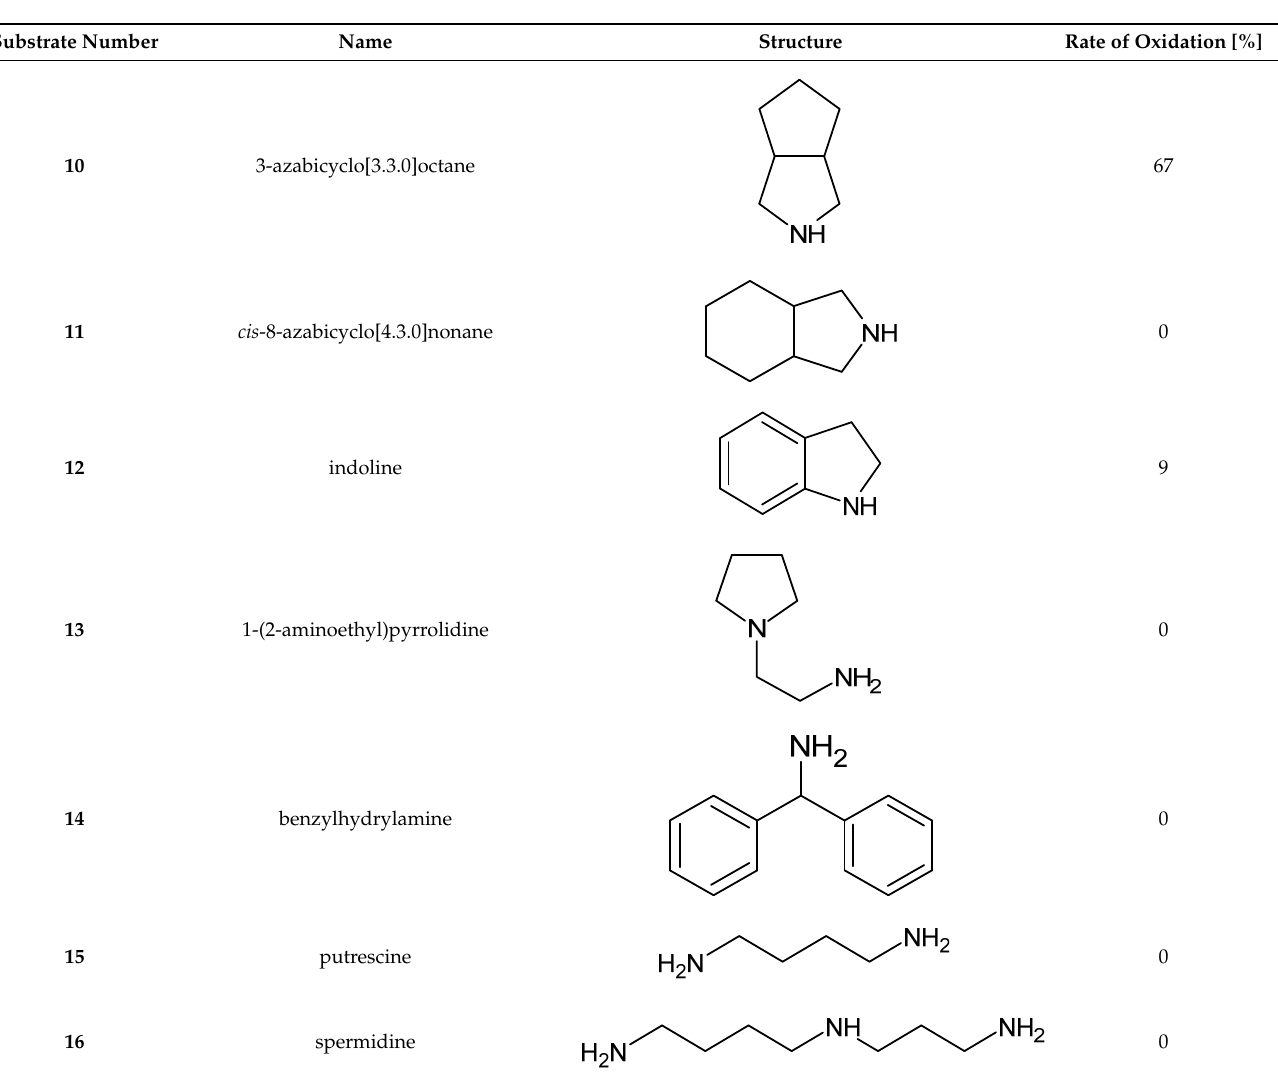
and indoline ( 12 ), for which the rates of oxidation relative to compound 9 are shown in Table 3. The compounds 2-azabicyclo[2.2.1]hept-5-en-3-one ( 7 ) and pyridine ( 8 ) were used as the negative controls because according to the literature, amides ( 7 ) or azines ( 8 ) cannot be oxidized by MAOs [12]. The highest level of activity was observed for substrate 9 , the secondary amine which was also the most actively converted by MAO P3 in the spectropho- tometric assay (Figure 2), whereas the lowest rate of oxidation was observed for substrate 12 .